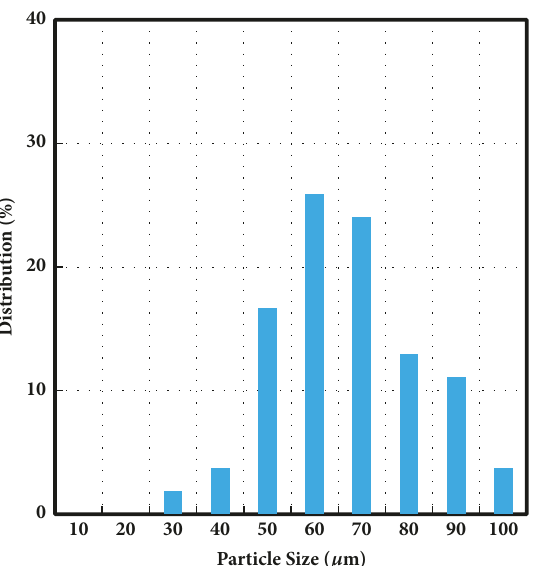
Figure 3: Particle size distribution with an average size of 67 𝜇 m. The sizes were measured using optical microscope images of Cu powders.